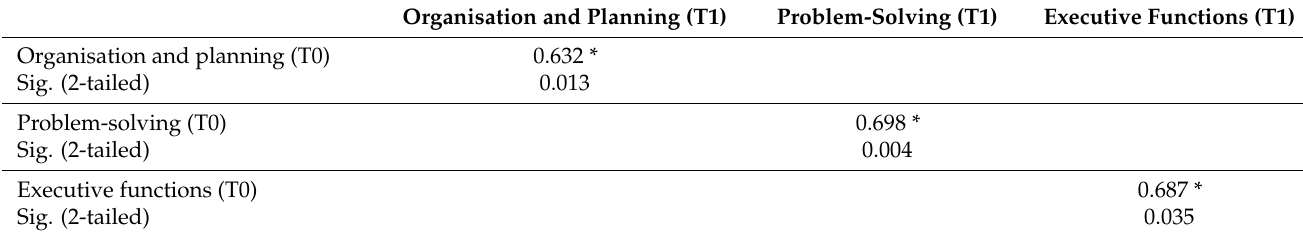
Table 7. Correlation study between variables at T0 and T1 of the TOL